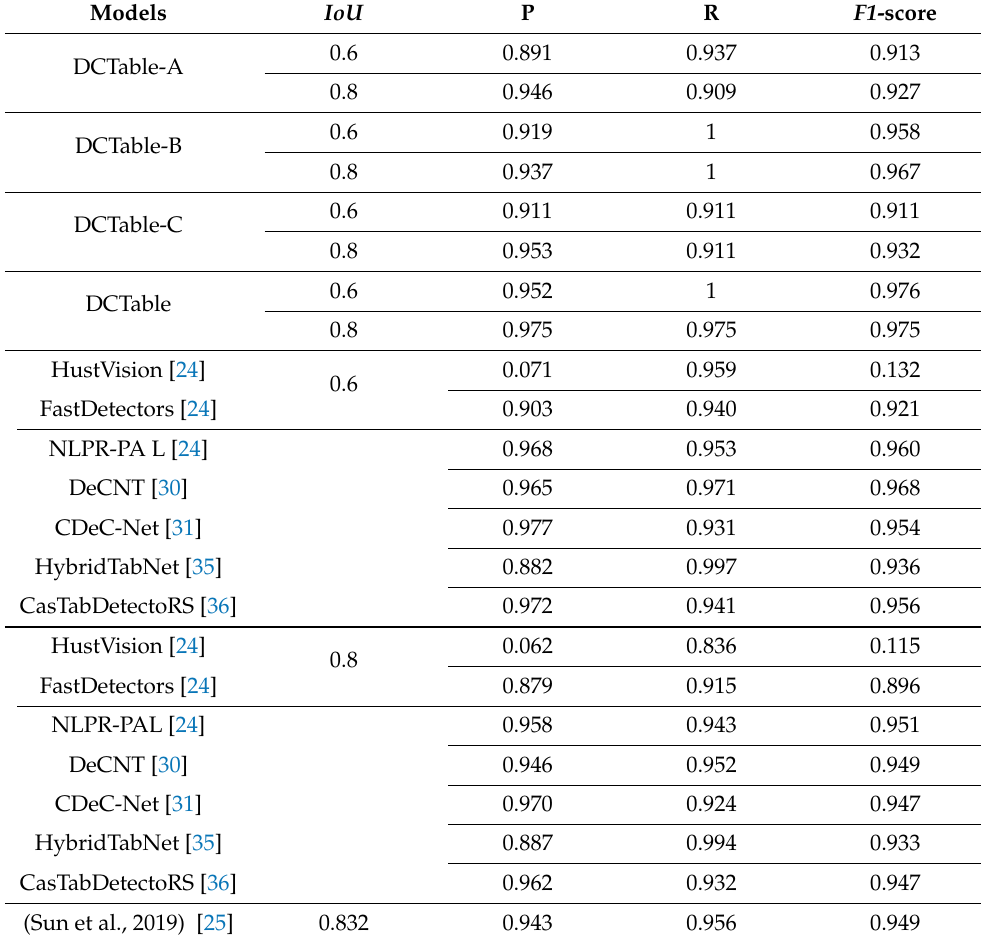
Table 1. Evaluation on ICDAR